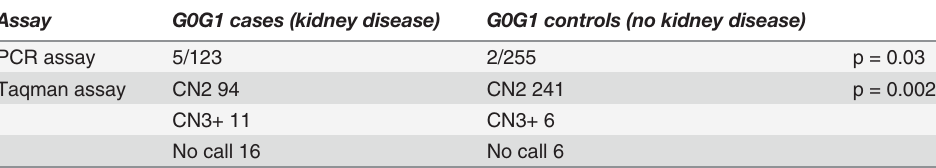
Table 1. Fraction of case and control samples in which an extra copy of APOL1 was detected by either a PCR assay designed to amplify across the insertional junction, or by a quantitative Taqman-based copy number